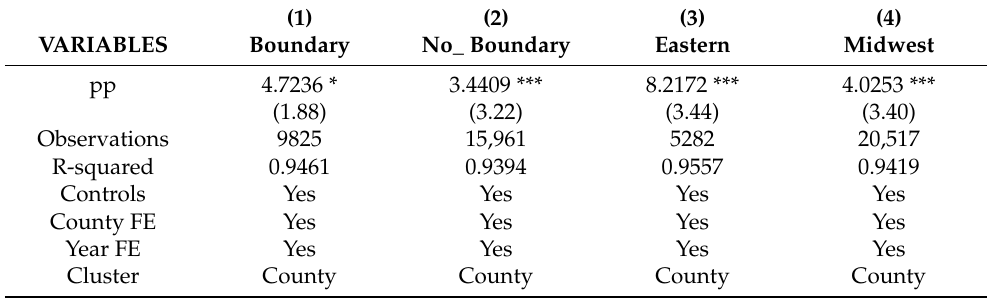
Table 7. The results of the geographical